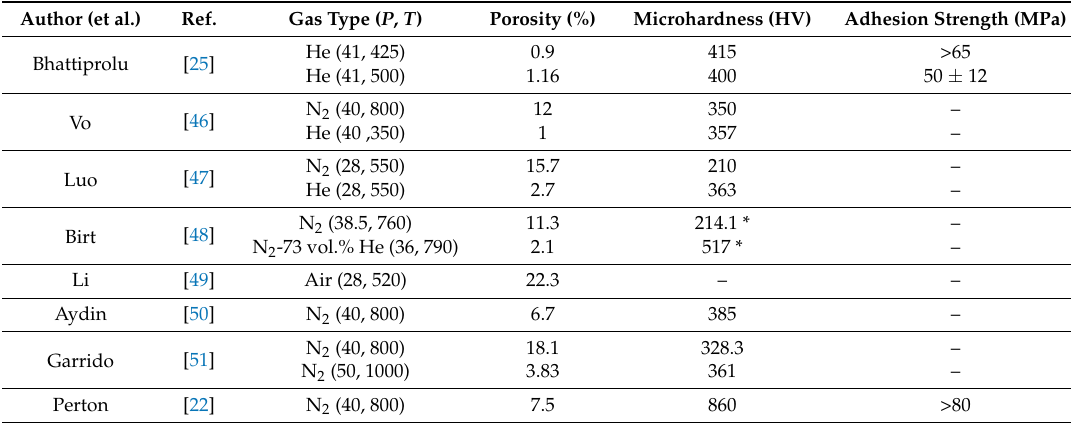
Table 1. Review of CS deposited Ti64 coatings on Ti64 substrates.